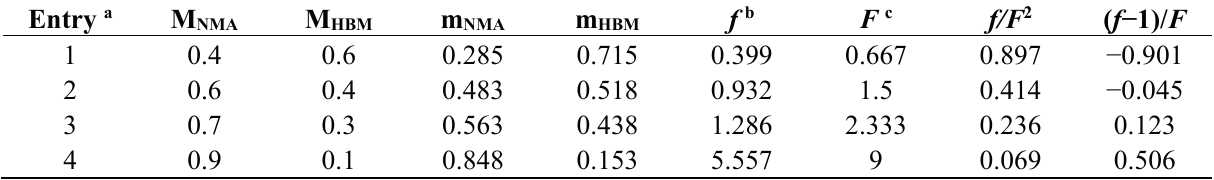
Table A1. Various parameters for calculating reactivity ratios of exo